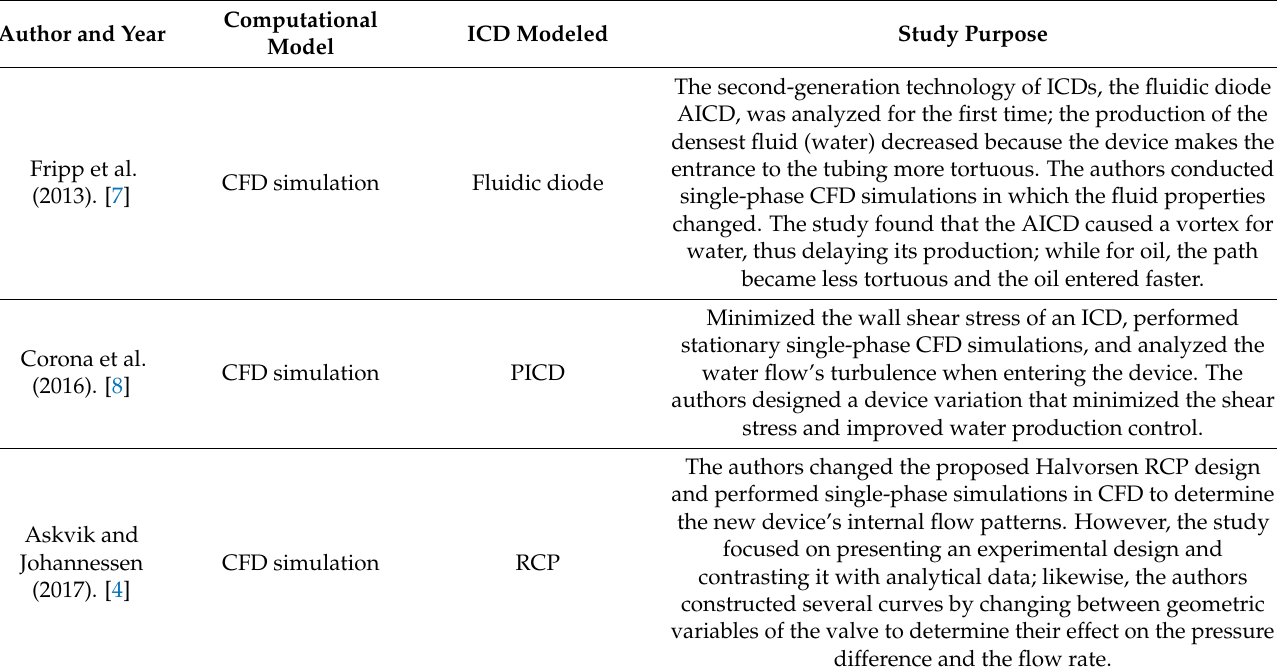
Table 1. Compilation of previous works on inflow control devices where the principal aim was to optimize designs using computational